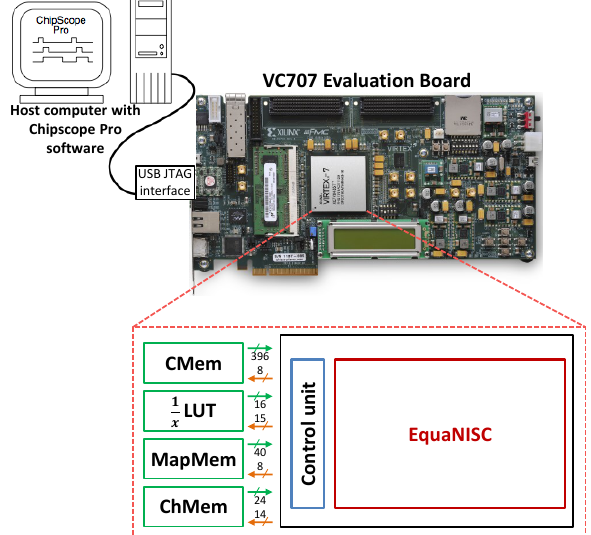
Figure 13. NISC-based MMSE MIMO turbo equalizer architecture on-chip